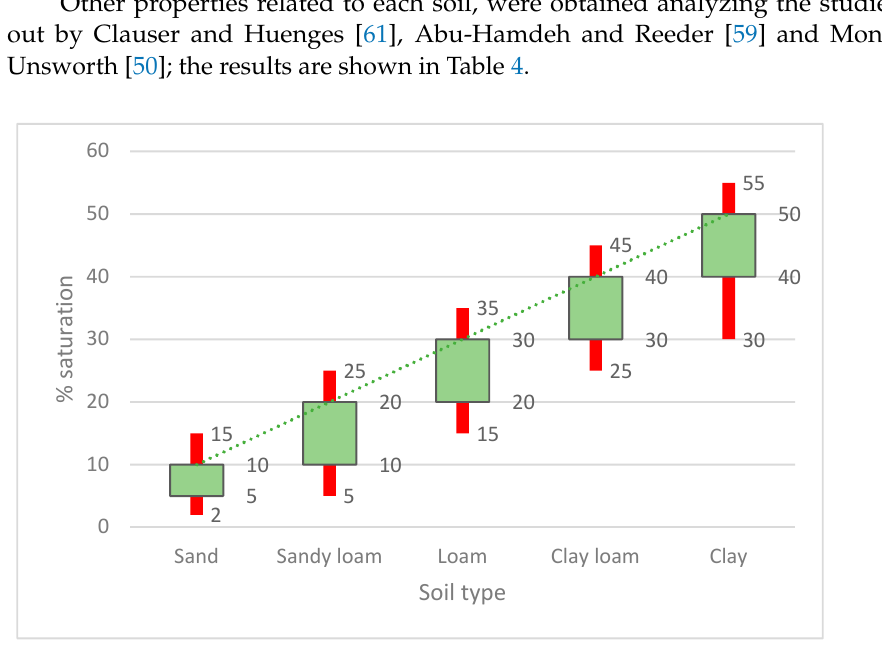
Table 3. Variation range for the variable parameters that influence solar absorptance coefficient and related references.